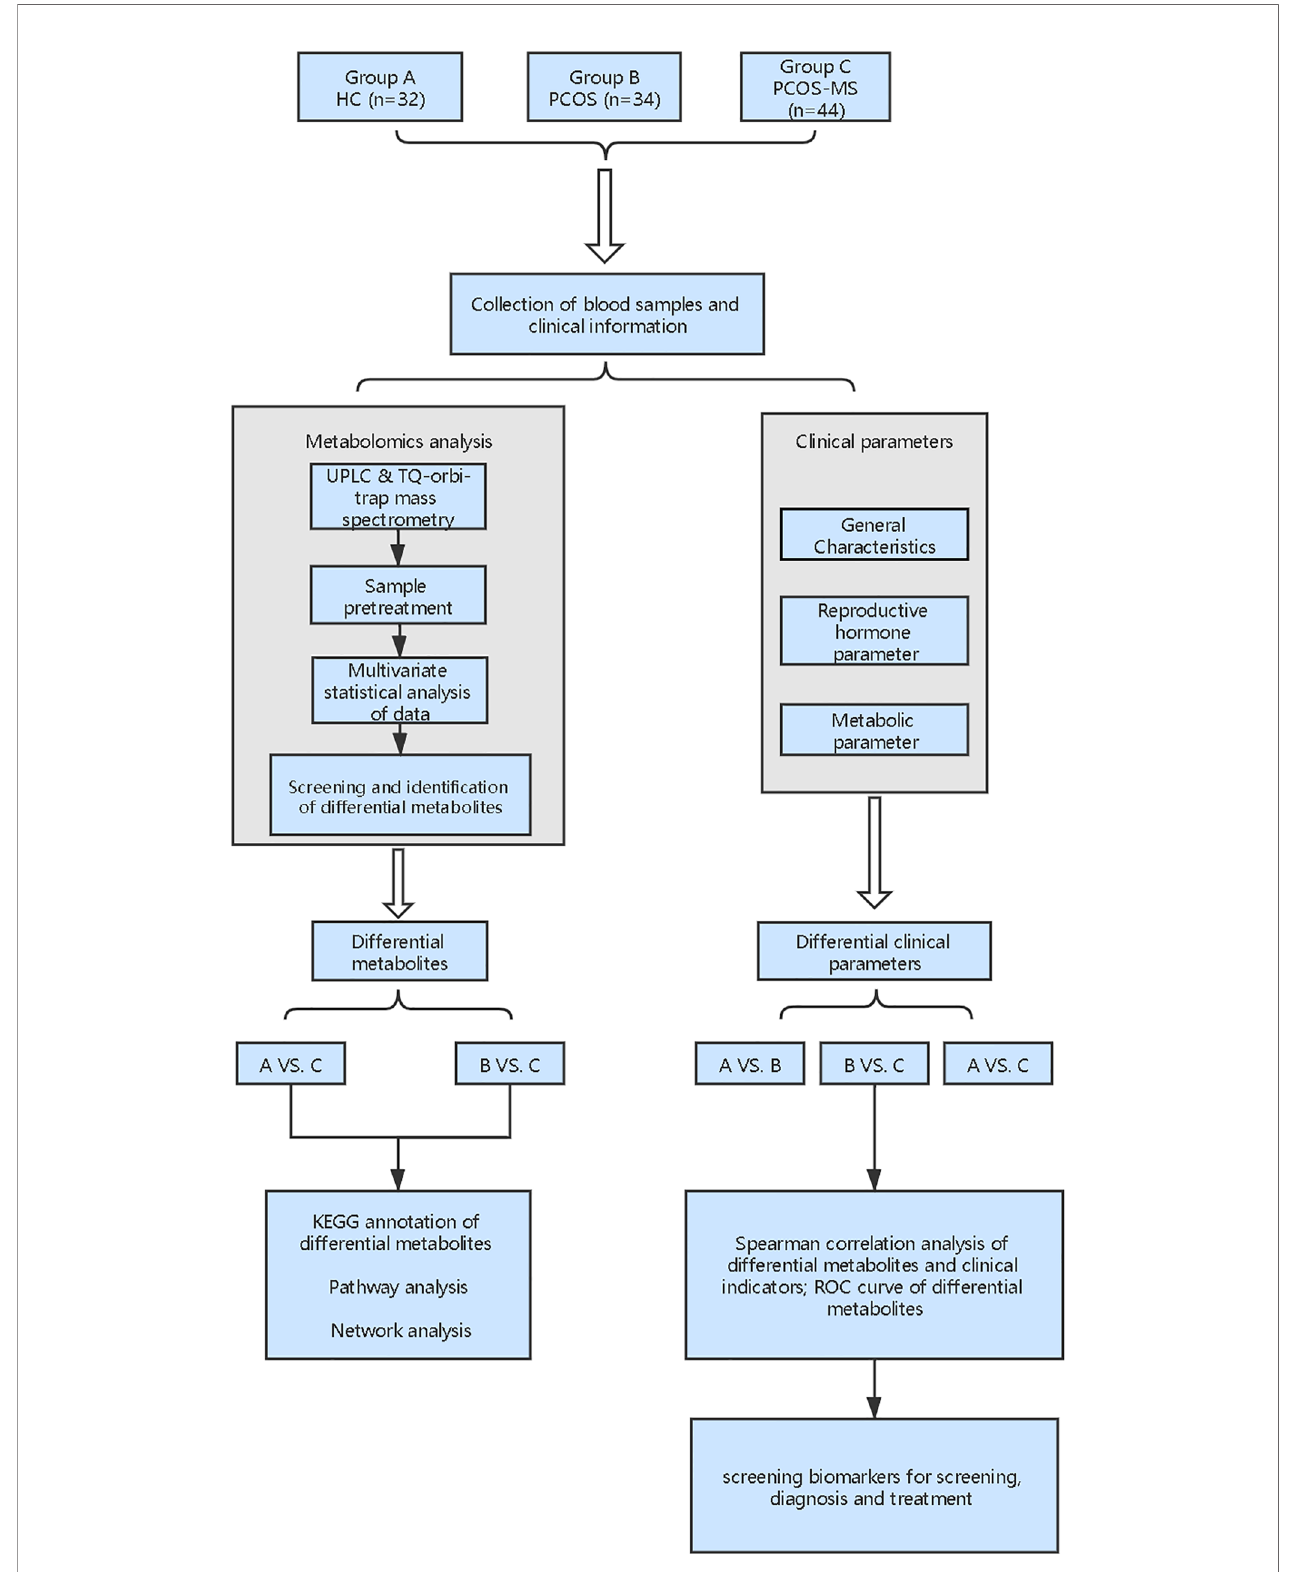
FIGURE 1 | Flowchart of study strategy in this